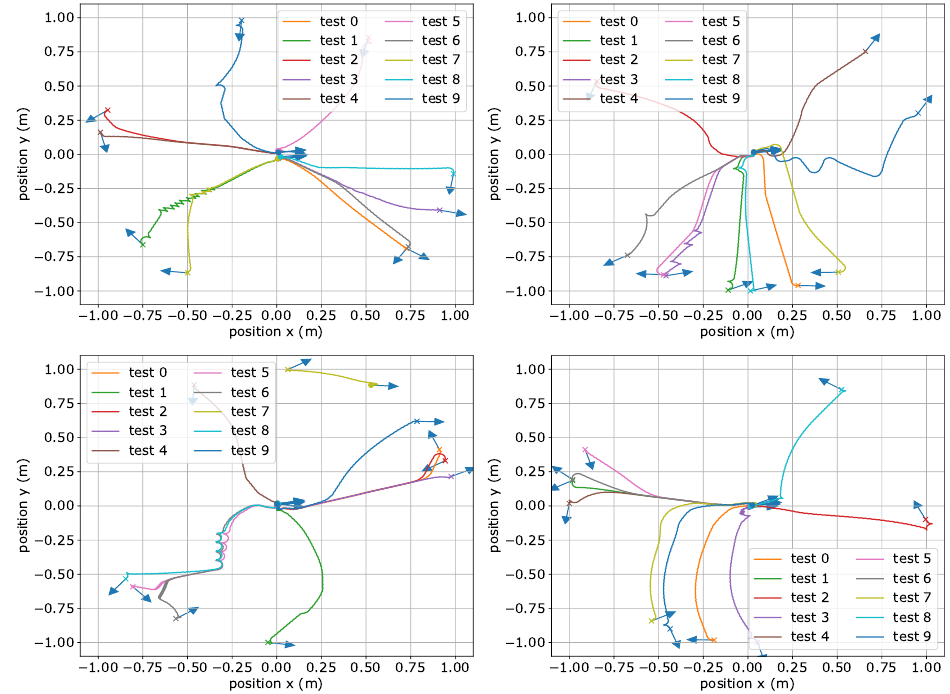
Figure 5. Example result for U control type, c 8 cost type, Gaussian White Noise Process and δ = 0.8 on X-Y